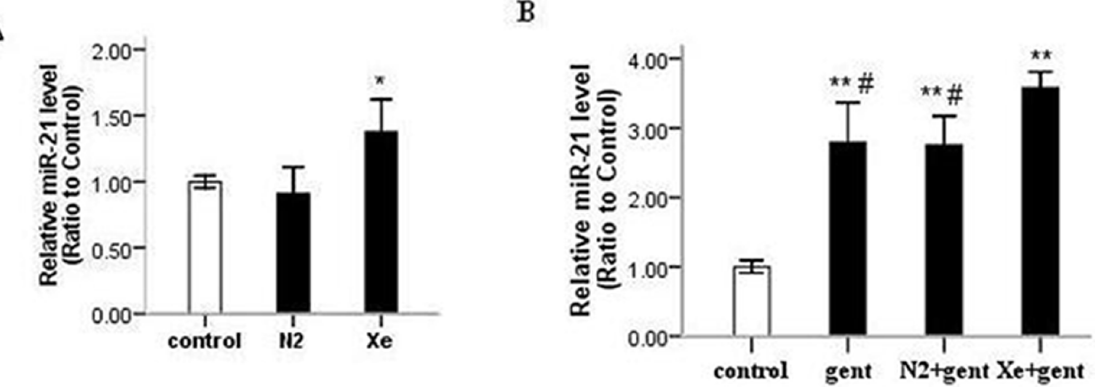
Figure 7. Expression of miR-21 in rat kidneys. A: Xe pretreatment significantly upregulated miR-21 in rat kidneys 24 hrs after Xe pretreatment. B: gentamicin treatment significantly up-regulated miR-21 4 days after 7-day gentamicin administration, which was further increased by Xe. *P , 0.05 vs . control group, **P , 0.01 vs . control group, # P , 0.05 vs. Xe + gentamicin group, n=5–6.